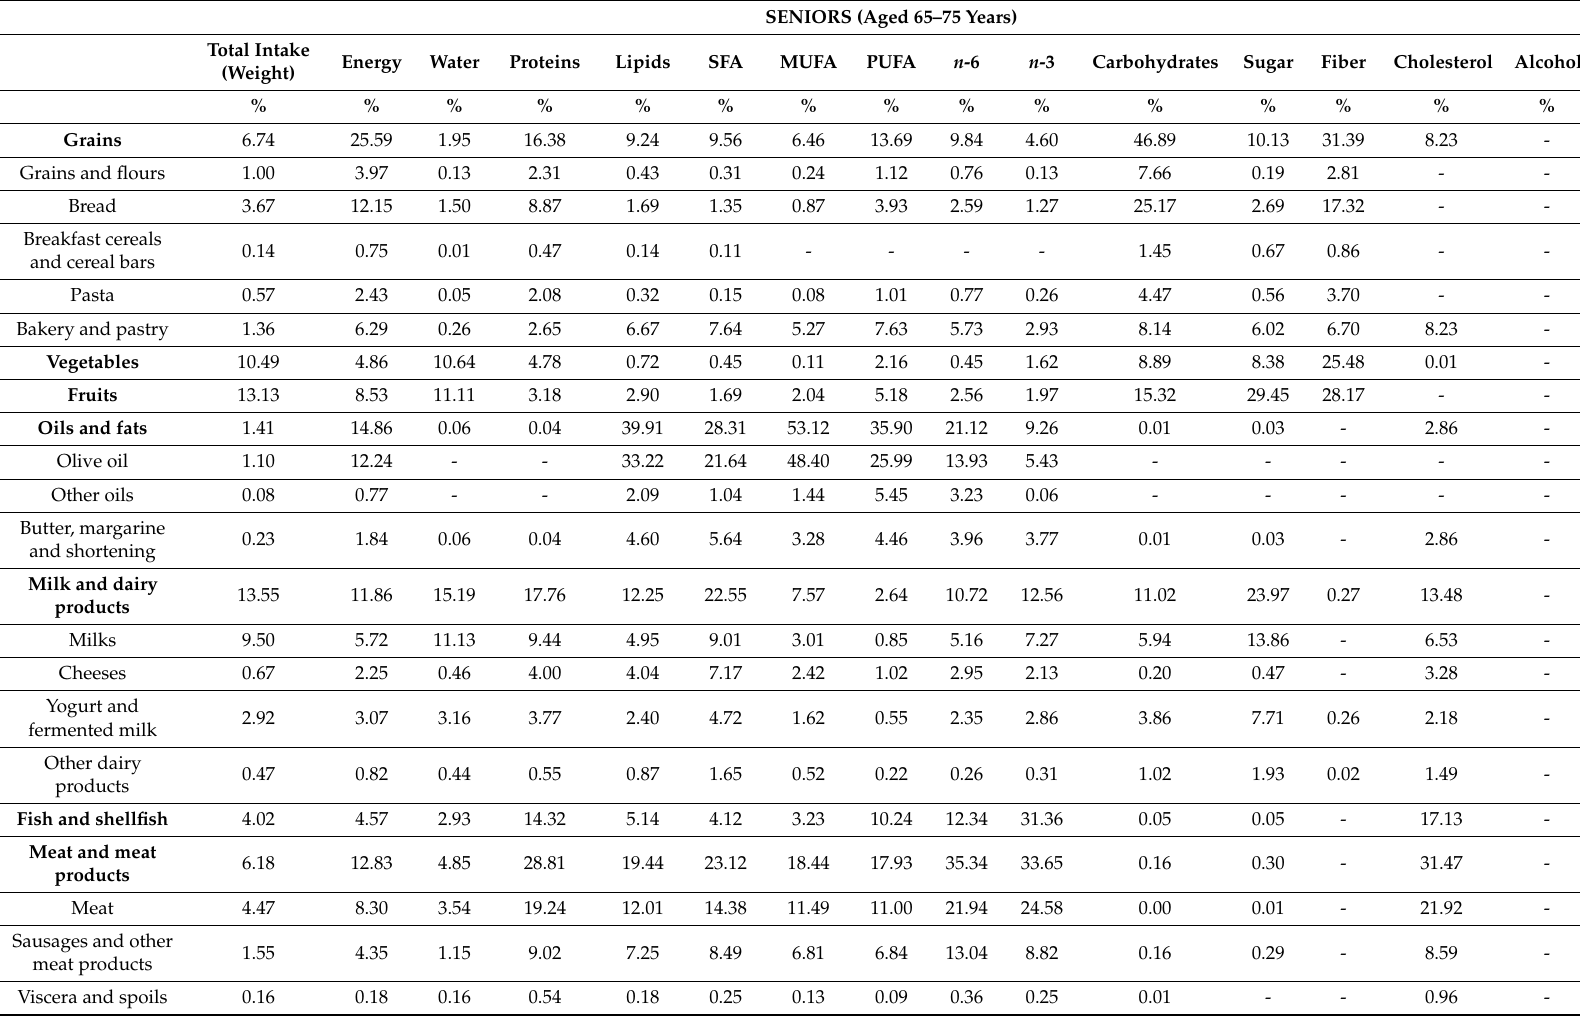
Table 7. Dietary sources of nutrients (%) from food groups/subgroups in the Spanish ANIBES study population: seniors aged 65–75 years ( n =